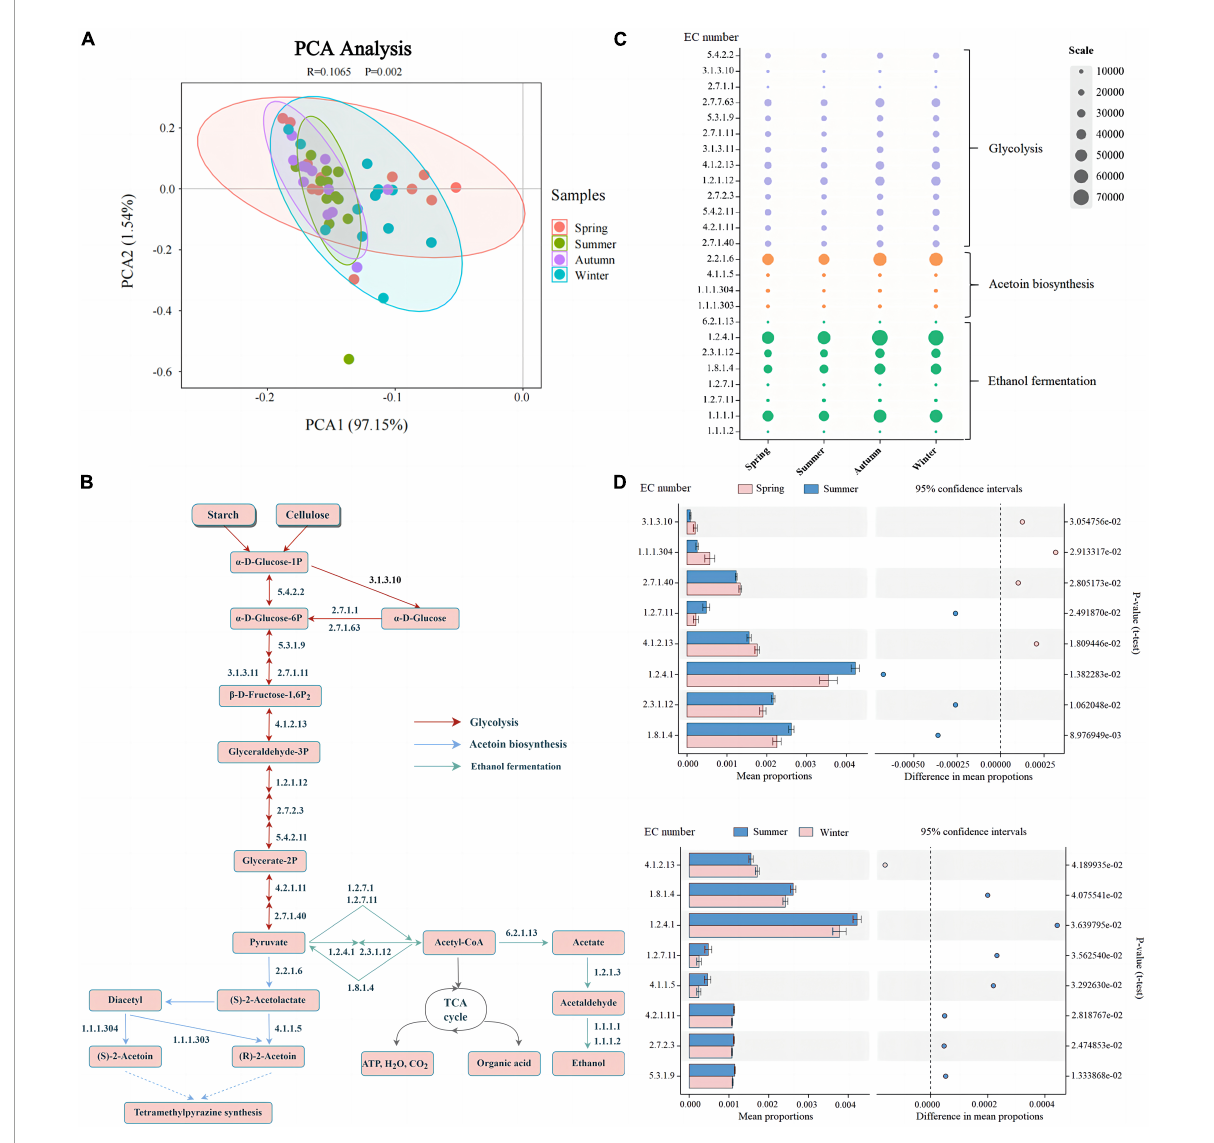
FIGURE6 Differences in predicted enzymes of bacterial community found in Daqu samples from different seasons. PCA with the β -diversity of all the predicted enzymes (A) . Profile of main enzymes related to glycolysis, acetoin biosynthesis, and ethanol fermentation (acetyl-CoA biosynthesis) (B) . Relative abundance distribution of enzymes (C) shown in subplot (B) , and significant changes between spring and summer and summer and winter (D)